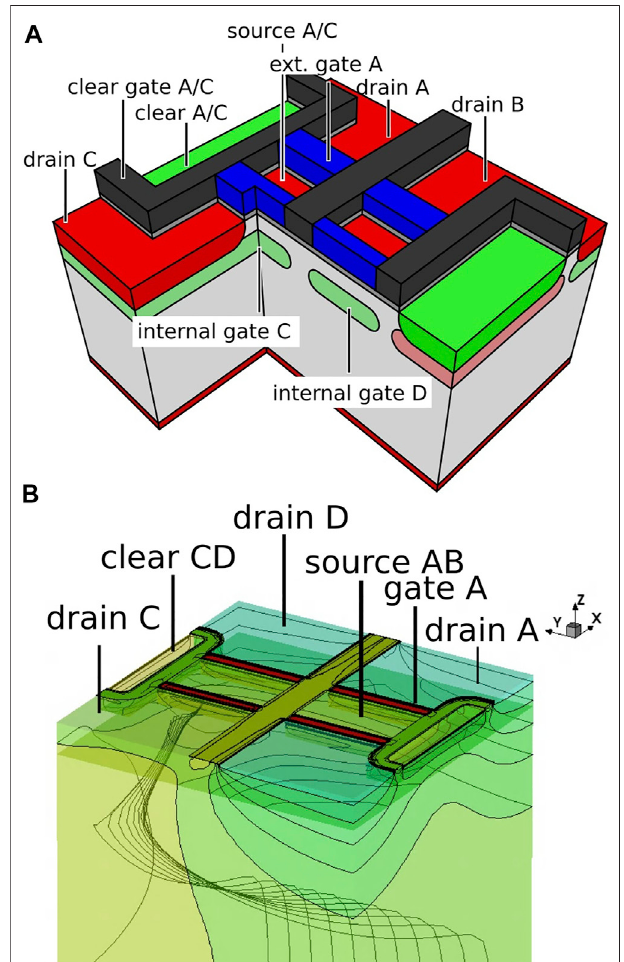
FIGURE 10 | (A) shows a sketch of a Quadropix DePFET. One super pixelconsistsoffourDePFETs,A,B,C,D[29].In (B) theelectrostaticpotential distribution inside one super pixel and the trajectories of charge carriers are shown to illustrate the working principle. charge generated inside the Bulk is collected in one of the four DePFETs